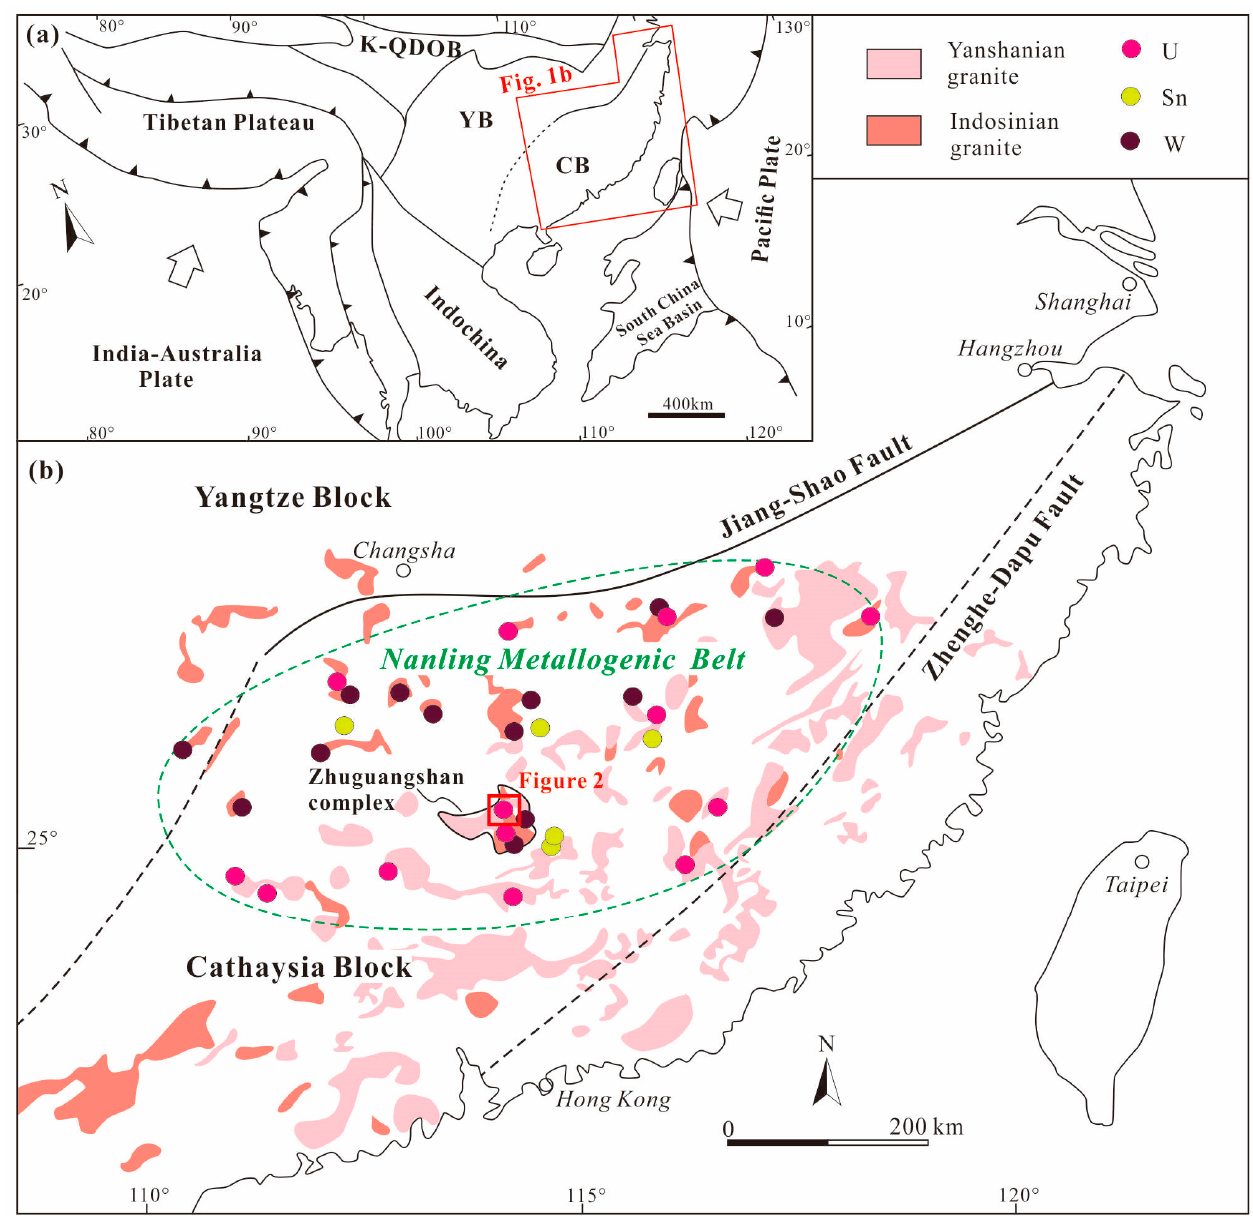
Figure 1. ( a ) Simplified geological map of South China showing the main tectonic units and ( b ) the location of W, Sn, and U deposits within the study region (modified after [42]). CB = Cathaysia Block, YB = Yangtze Block, K-QDOB = Kunlun-Qingling-Dabie Orogen Belt.